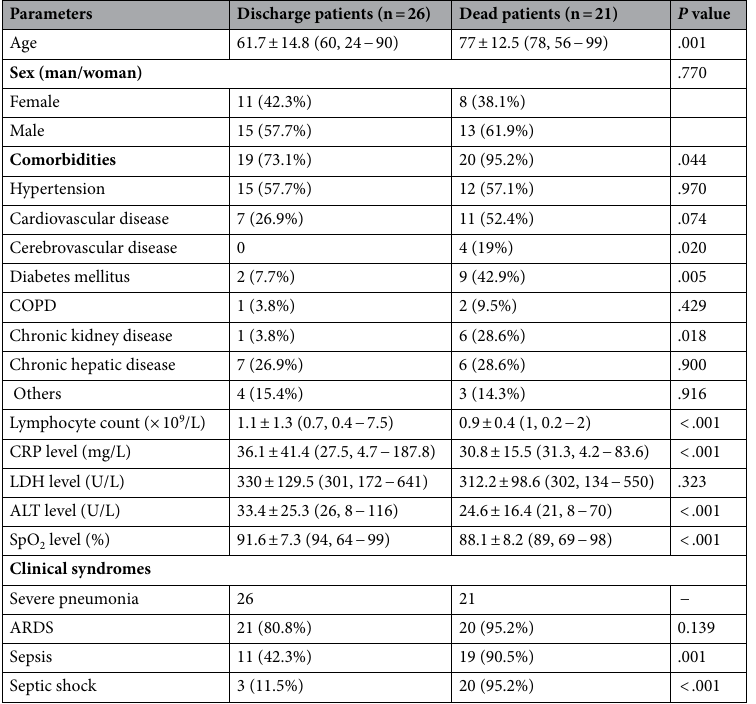
Table 1. Baseline characteristics and clinical syndromes of patients with severe COVID-19. Except where otherwise indicated, data are mean ± SD (median and range) of age or number (%) of patients. COPD chronic obstructive pulmonary disease, CRP C-reactive protein, LDH lactate dehydrogenase, ALT alanine aminotransferase, SpO 2 pulse oxygen saturation, ARDS acute respiratory distress